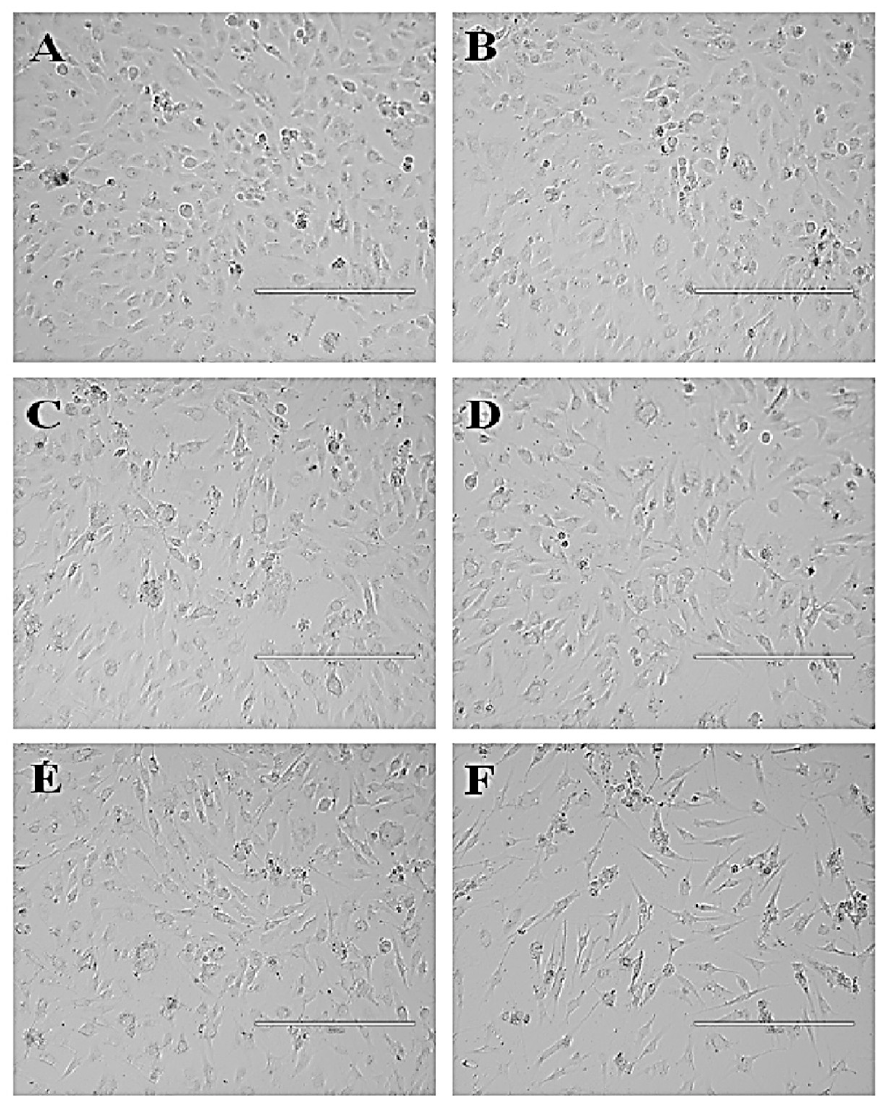
Figure 5. Photomicrographic represents effect of 50% ME of P. niruri treatment on EA.hy926 cell viability. Where ( A ) = 0.5% DMSO (control), ( B ) = 12 µg/mL P. niruri , ( C ) = 25 µg/mL P. niruri , ( D ) = 50 µg/mL P. niruri , ( E ) = 100 µg/mL P. niruri , and ( F ) = 10 µg/mL betulinic acid (+ve control). Photos were taken at 10× magnification (scale bar 400 µm).